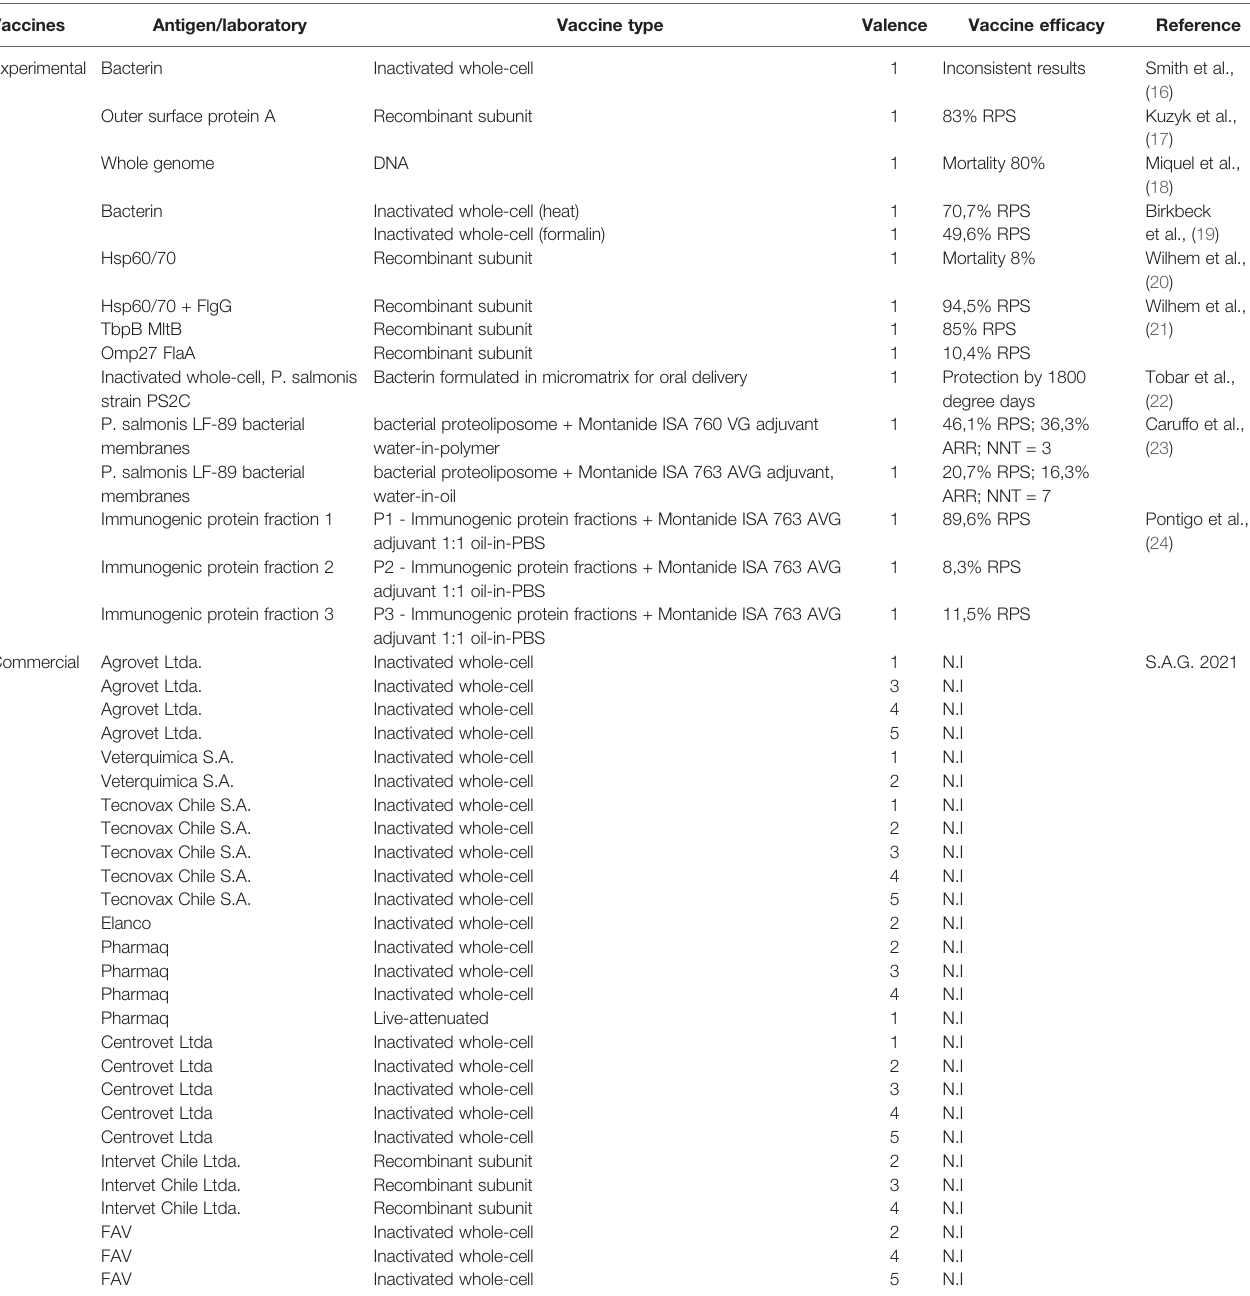
TABLE 1 | Summary of experimental studies on ef fi cacy evaluation of injectable and oral vaccines, types of antigens used and availability of commercial